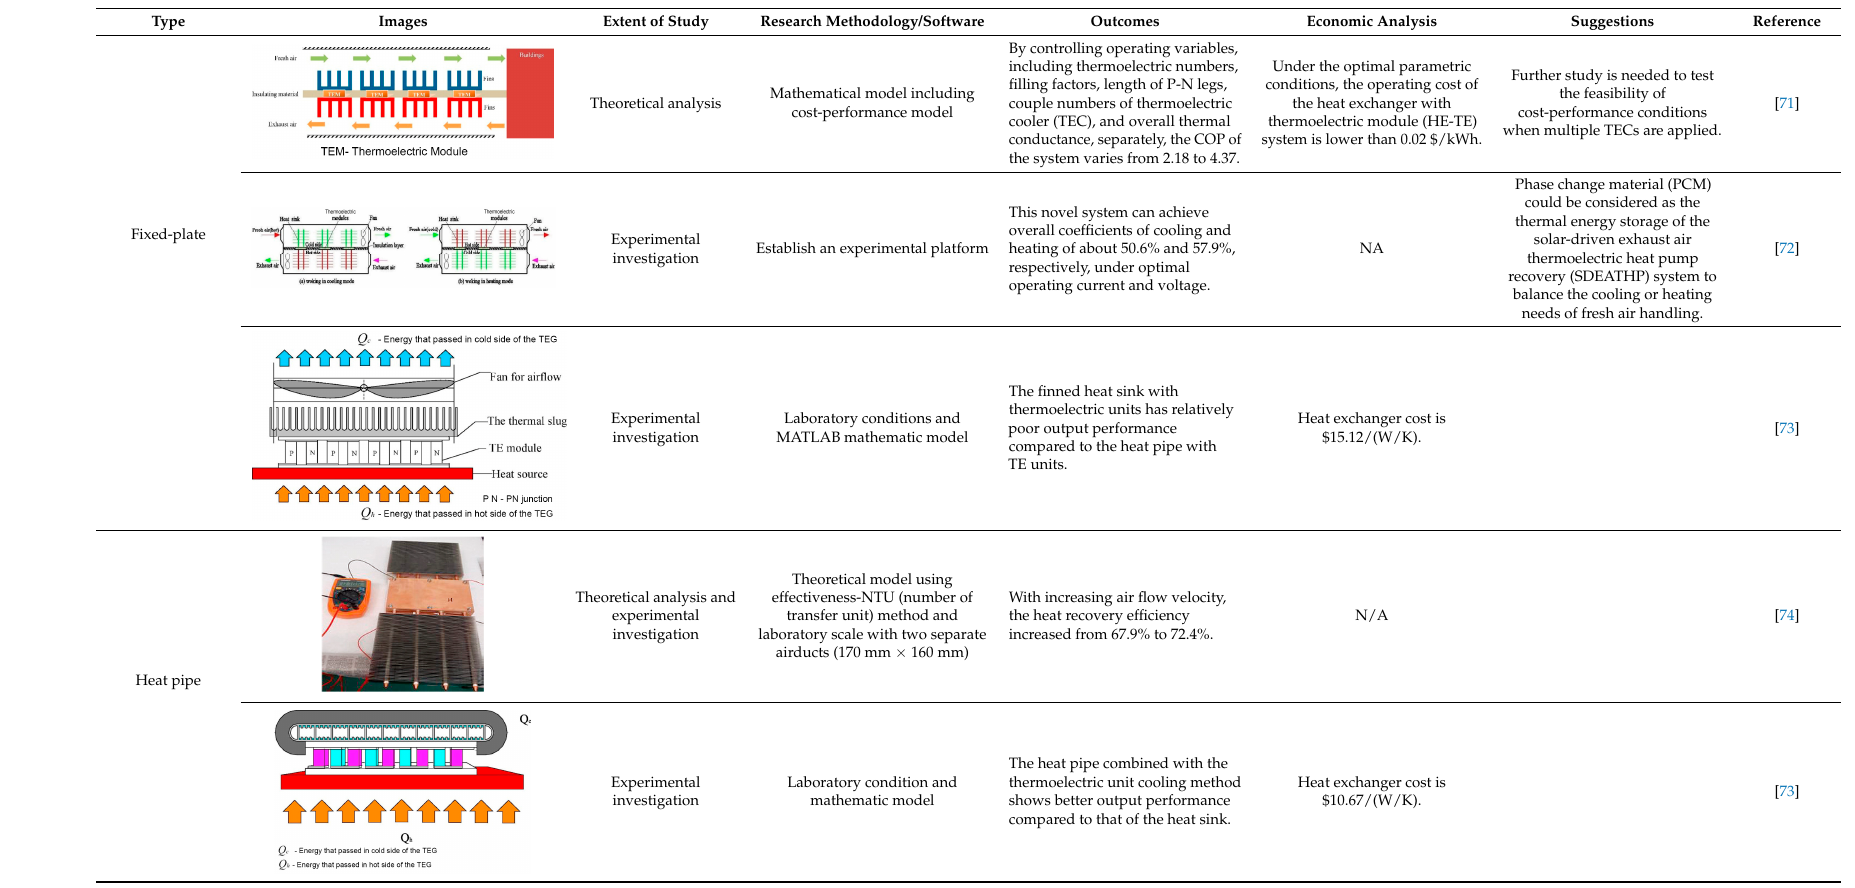
Table 4. Heat recovery systems integrated with thermoelectric (TE) modules.